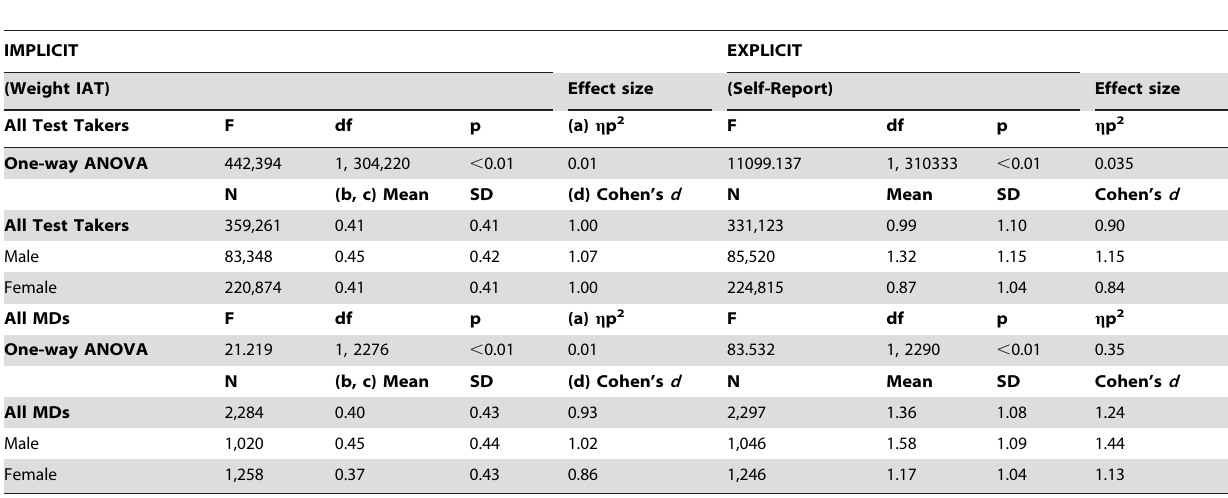
Table 2. Implicit and Explicit Attitude Measures for All Test Takers and All MDs (medical doctors) and by Gender.